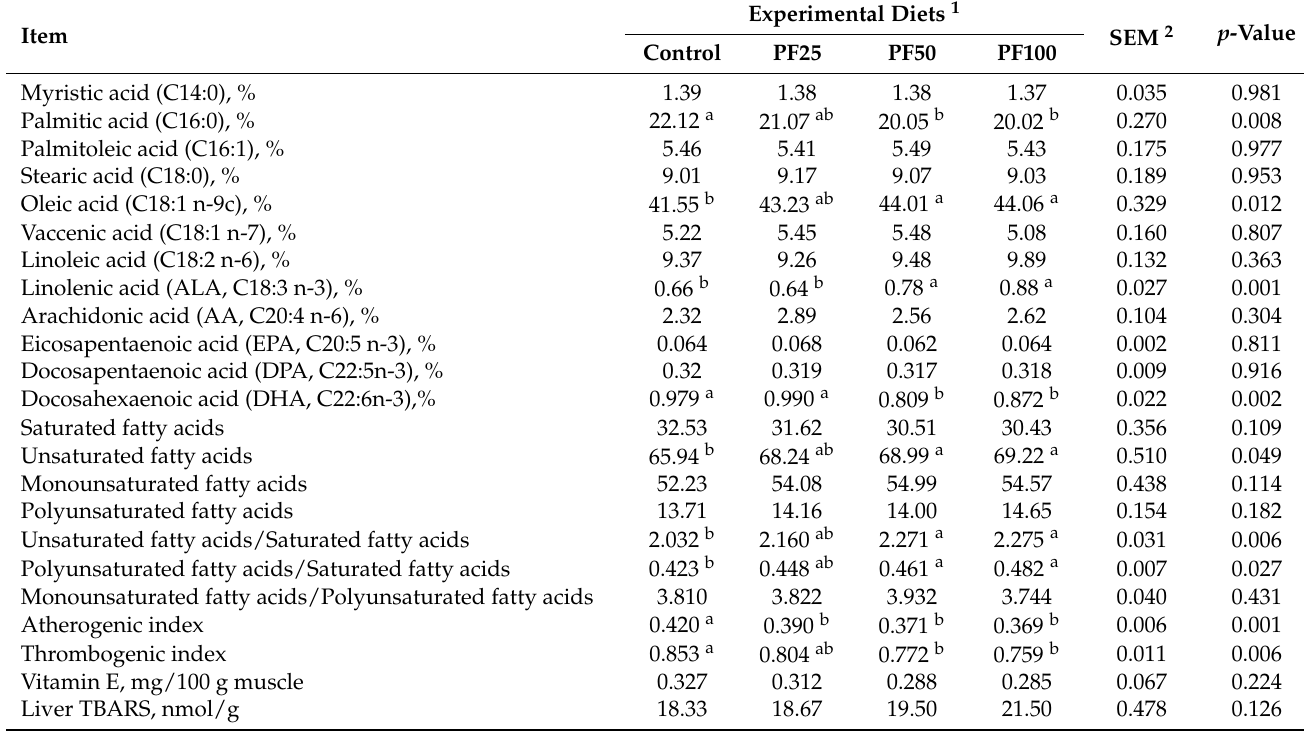
Table 6. Effect of replacing soybean oil with poultry fat on fatty acids profile of broilers pectoral